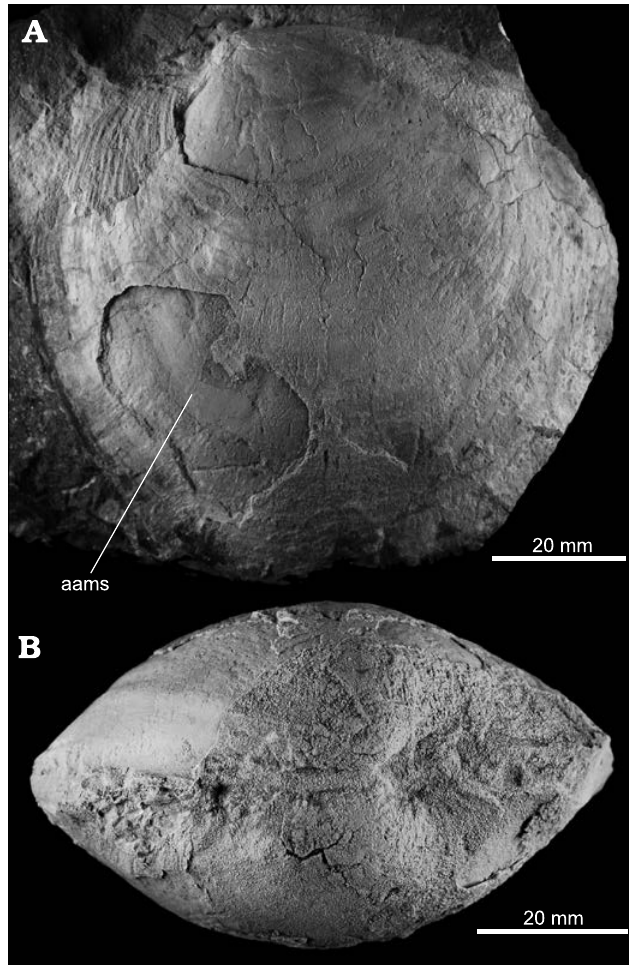
Fig. 8. The lucinid bivalve Meganodontia hoernea (Des Moulins, 1868) from Upper Miocene seep deposits of the Amlang Formation in Pangasinan pro vince, Luzon, Philippines. A . NRM Mo 192403, isolated LV showing anterior adductor muscle scar (aams). B . NRM Mo 192404, small, articu- lated specimens in dorsal